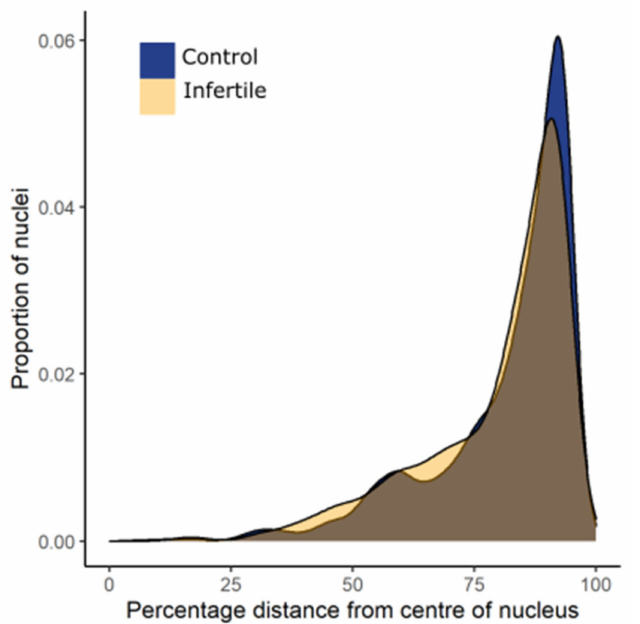
Figure 6. Frequency density of the number of nuclei for each cohort at each fractional distance from the center of the nucleus. Telomeres in infertile males occupied more internal regions of the nucleus, a subtle but significant ( p < 0.001)